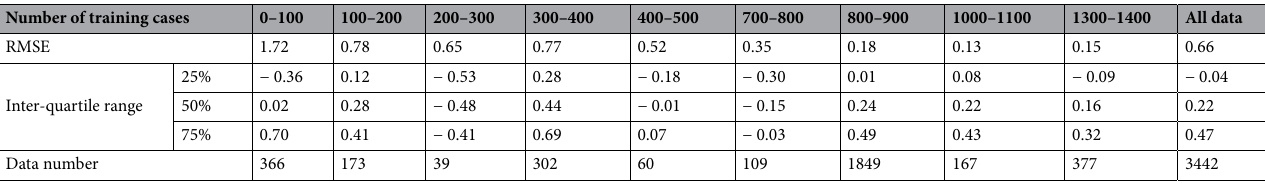
Table 4. Evaluation result of the ANN value for each number of training cases. All data numbers are